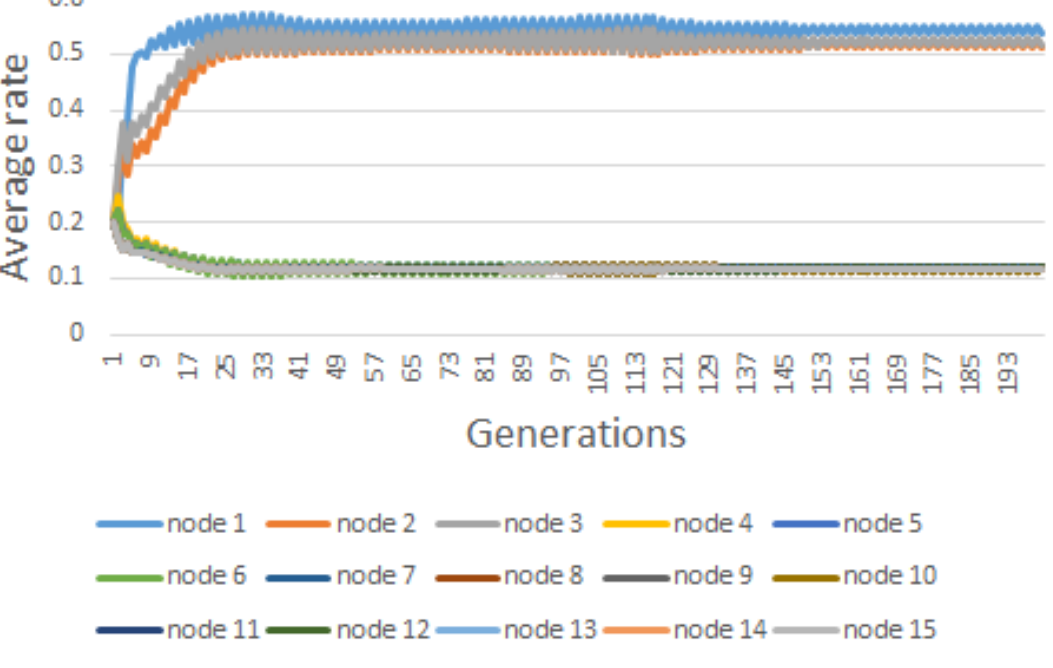
Figure 9. Evolution graphs for average defense rate for the nodes of the case study. The defender’s budget equals to 3.0. The x-axis presents the generations. The y-axis presents the evolution of average